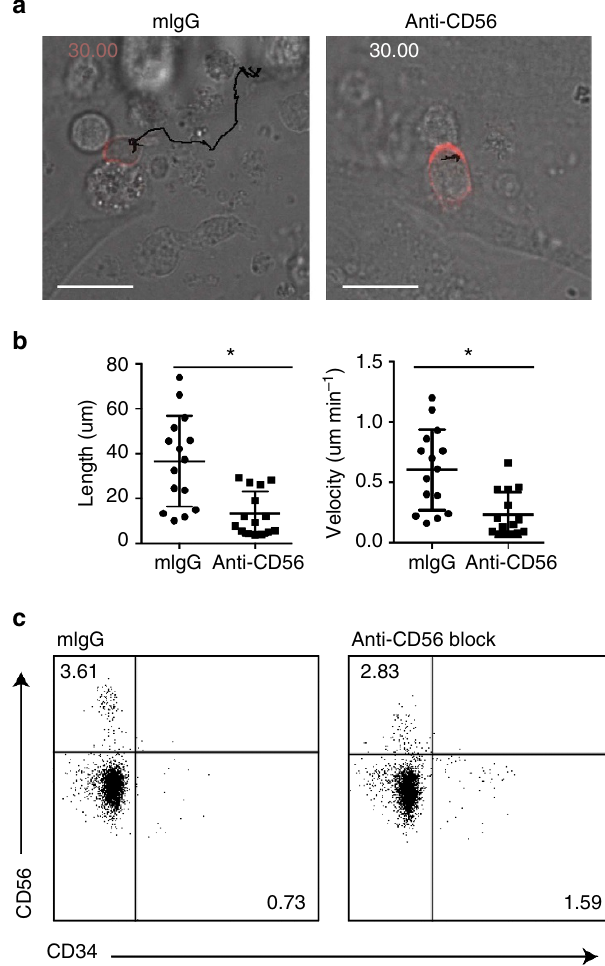
Figure 7 | Blocking CD56 ligation throughout development decreases the frequency and motility of mature NK cells. CD34 þ hematopoietic stem cells were purified from peripheral blood and differentiated in vitro to become NK cells in the presence of anti-CD56 blocking antibody or mouse IgG as a negative control as described in Methods. 21 days after the initiation of culture cells were removed from culture and analysed by FACS or incubated on fresh EL08.1D2 stromal cells for 4h before imaging and cell tracking as in Fig. 1. ( a ) Representative track from mIgG (left) or anti-CD56 (right) treated cultures is shown with its track from 0 to 30min overlaid; red, CD56. See also Supplementary Movies 7 and 8. Scale bar, 10 m m. ( b ) Cells were tracked as in Fig. 1. n ¼ 15 from one representative experiment of 3. Data are represented as mean ± s.d. * P o 0.05 by Student’s unpaired t -test. ( c ) FACS analysis of NK cell maturation markers from one representative experiment.